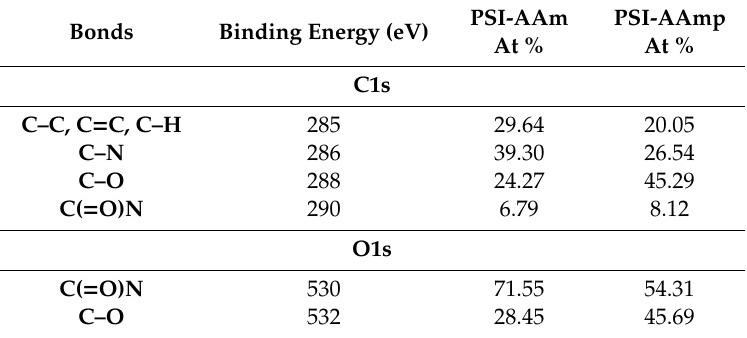
Table 2. High-resolution C1s and O1s XPS spectra of PSI-AAm and PSI-AAmp.